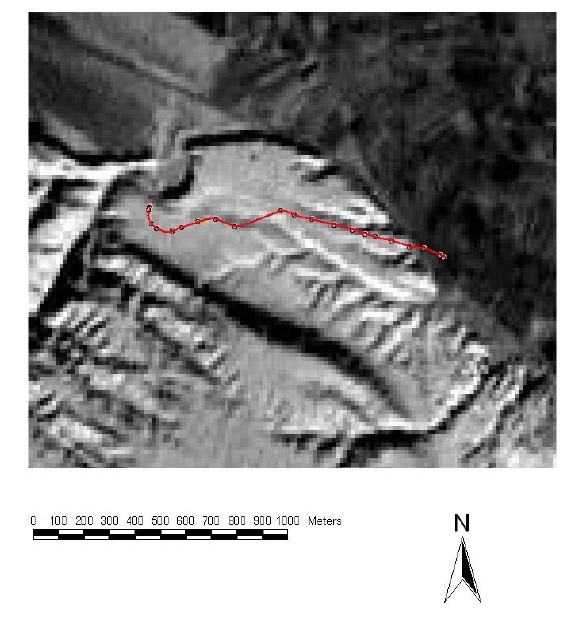
Figure 11. An ancient road alignment H 13 plotted with GPS waypoints on a Landsat image, which displays a Pleistocene terrace (Plateau 1) on the Euphrates. A close-up.